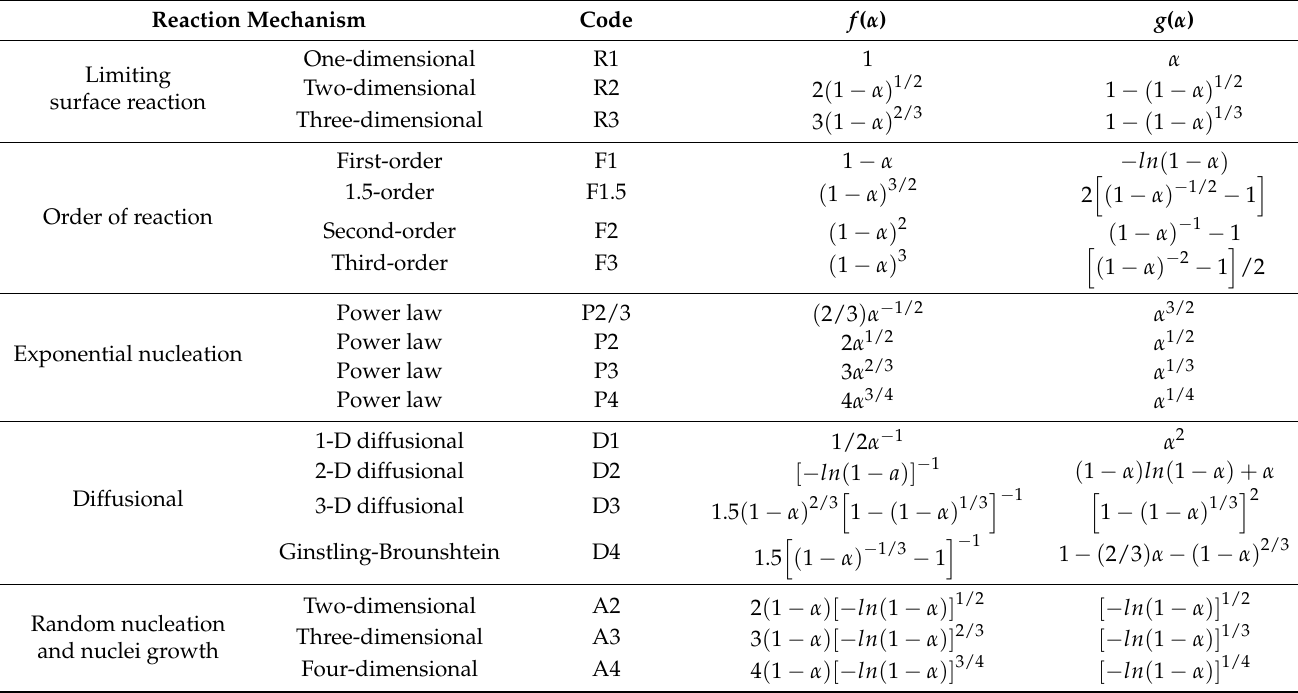
Table 2. The common kinetic reaction models